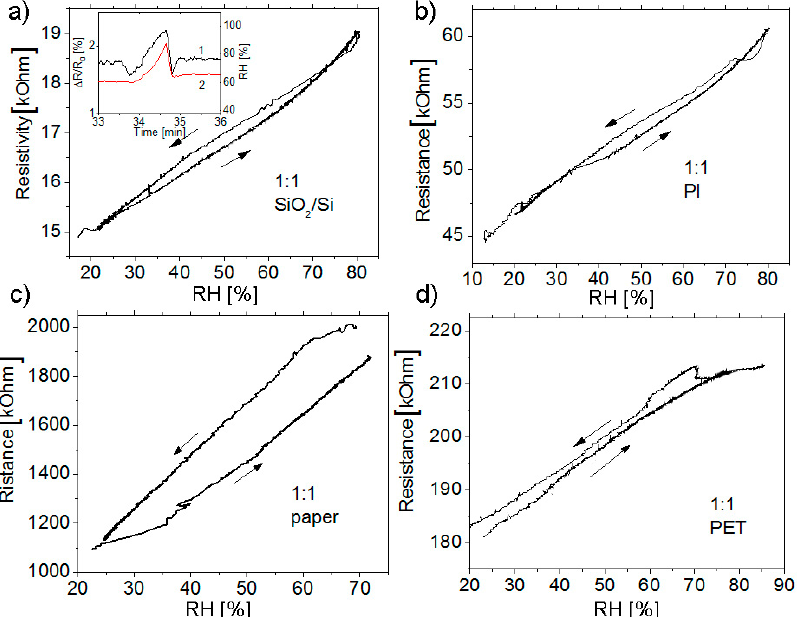
Figure 4. Dependences of resistance on the humidity for C1a1 and C1b strips ( a , b ) and for test structures ( c , d ) grown on different substrates. The resistance was measured on changing the humidity in two directions. The composite graphene layer is PEDOT: PSS 1:1. The humidity was measured with the HIH4000 industrial humidity sensor. Inset ( a ): the relative change in the resistance of the C1a1 film during a sharp decrease of humidity in the chamber. Red line (curve 2) shows the data taken from the HIH4000 humidity sensor.